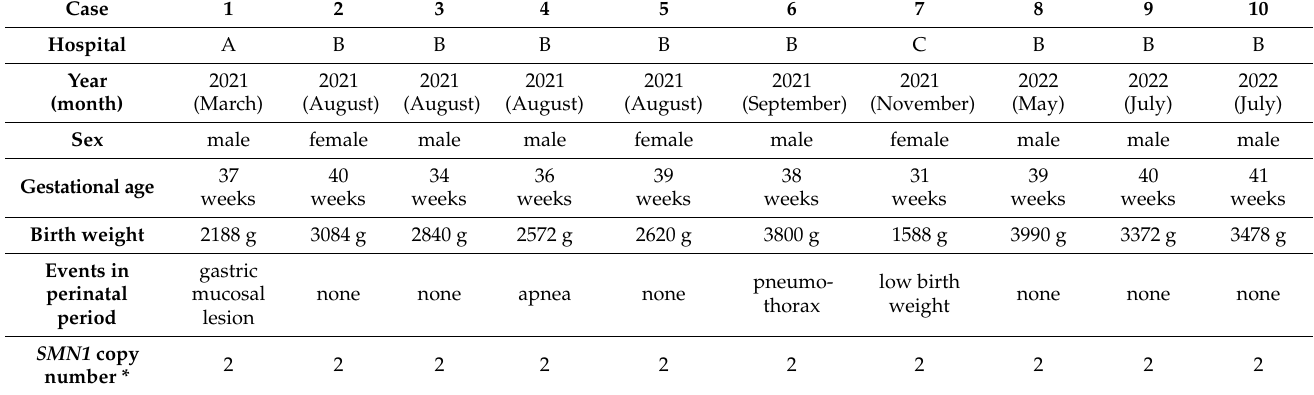
Table 3. False-positive